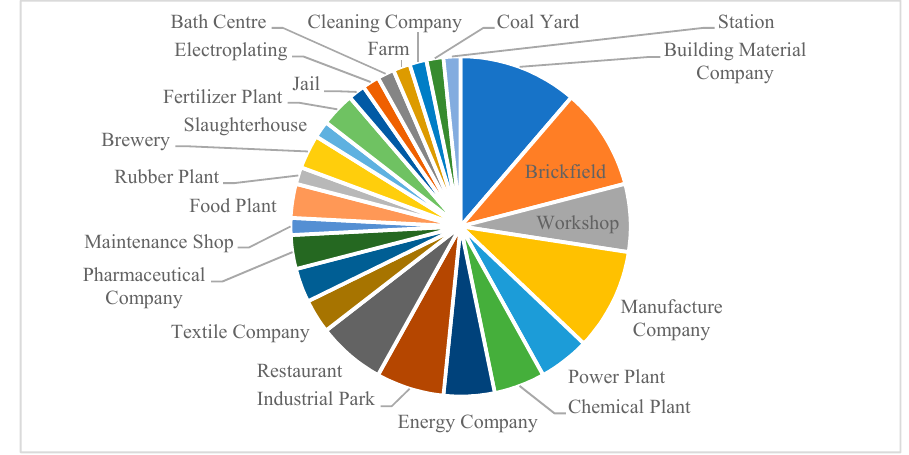
Figure 4. The distribution of pollution subjects.